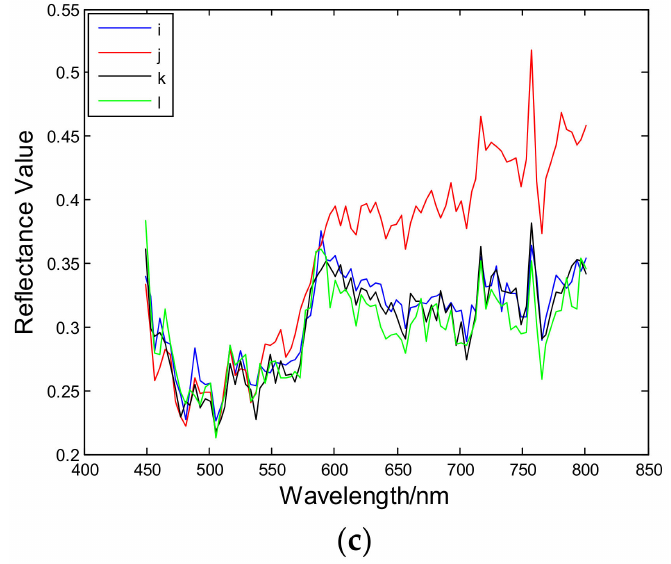
Figure 9. Spectral reflectance of target in visible light band. ( a ) Spectral reflectance of a–d. ( b ) Spectral reflectance of e–h. ( c ) Spectral reflectance of i–l. The grayscale images of different wavebands obtained by near-infrared imaging spectrometer are shown in Figure 10, below, and the spectral reflectance curves of different ground objects are shown in Figure 11.